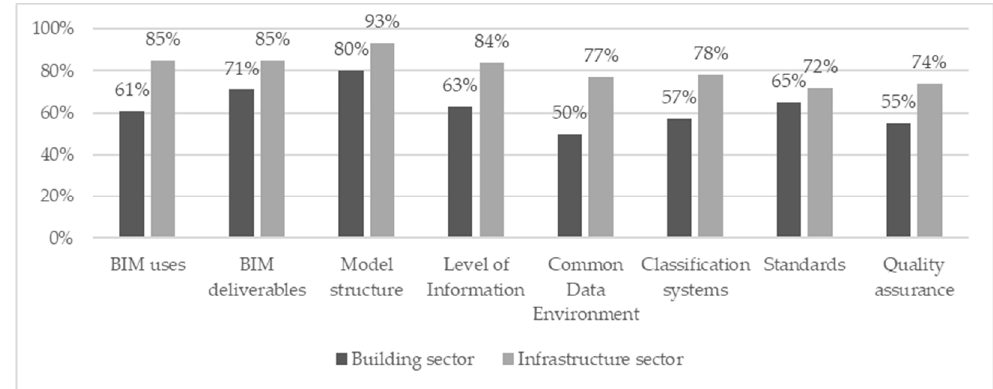
Figure 13. Level of inclusion of BIM requirements in Spanish tenders by sectors, in the period of January 2020–August 2021.